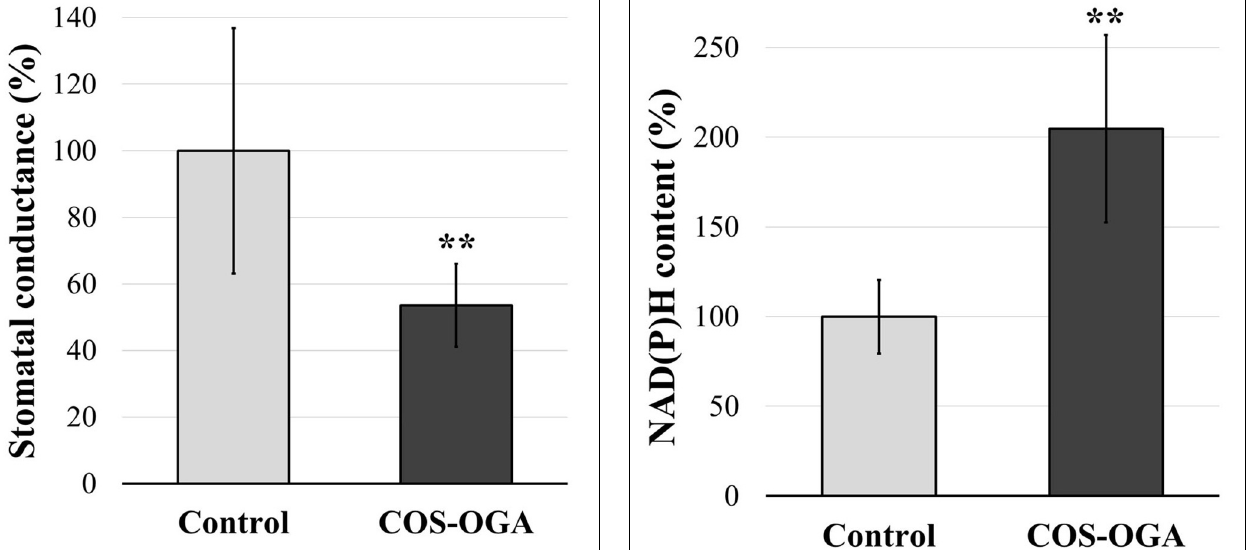
FIGURE 6 | Reduced nicotinamide adenine dinucleotide phosphate [NAD(P)H] content of tomato leaves after three sprayings with chitooligosaccharides–oligogalacturonides (COS-OGA; 62.5 mg/l). Tomato leaves were harvested 24 h after the third treatment. The average NAD(P)H content is expressed as the average percentage of the control ± standard deviation ( n = 6). **indicates a statistically significant difference to control according to Student’s t test ( p < 0.01, R